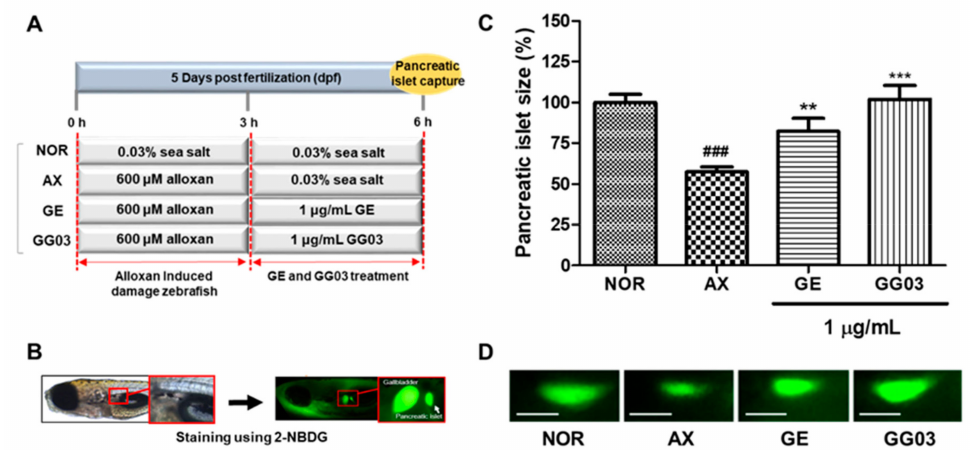
Figure 1. E ff ect of GE and GG03 on alloxan-induced pancreatic islet-damaged zebrafish. ( A ) Experimental scheme ( B ) Pancreatic islet identification using 2-NBDG dye. ( C ) Pancreatic islet size of each group. ( D ) Pancreatic islet images. ( ### p < 0.001; compared to normal), (** p < 0.01, *** p < 0.001; compared to alloxan). Scale bar = 100 µ